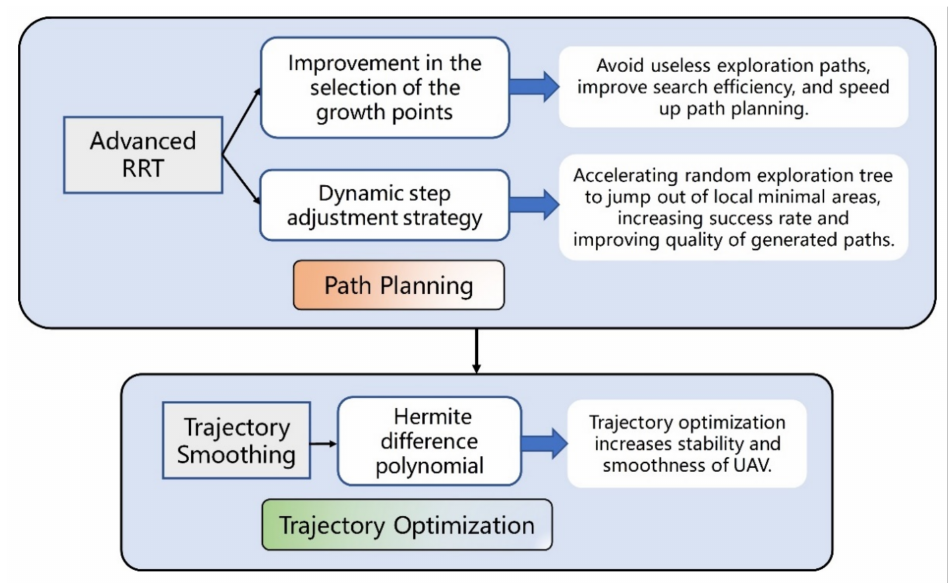
Figure 7. An overview of the proposed Improved RRT path planning algorithm and trajectory optimization